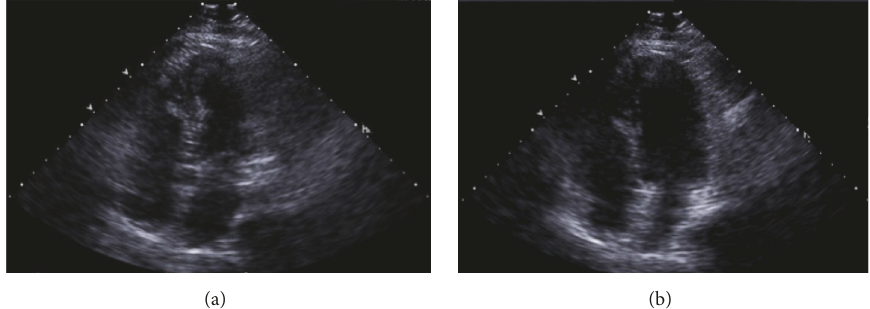
Figure 2: Systolic (a) and diastolic (b) apical 4 chamber transthoracic echocardiographic images. Ejection fraction estimated to be 62%. No regional wall abnormalities or valve pathology was